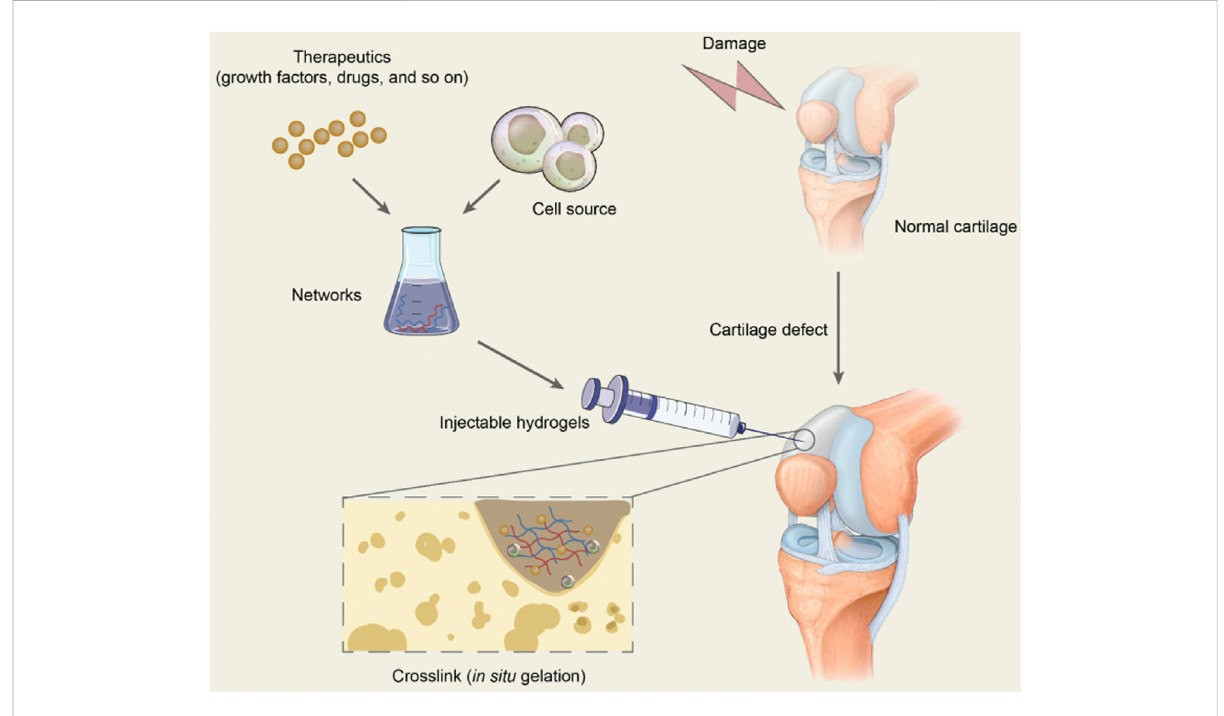
FIGURE 1 Schematic diagram of hydrogel injection in repairing cartilage defect. Adapted with permission of Wu et al.